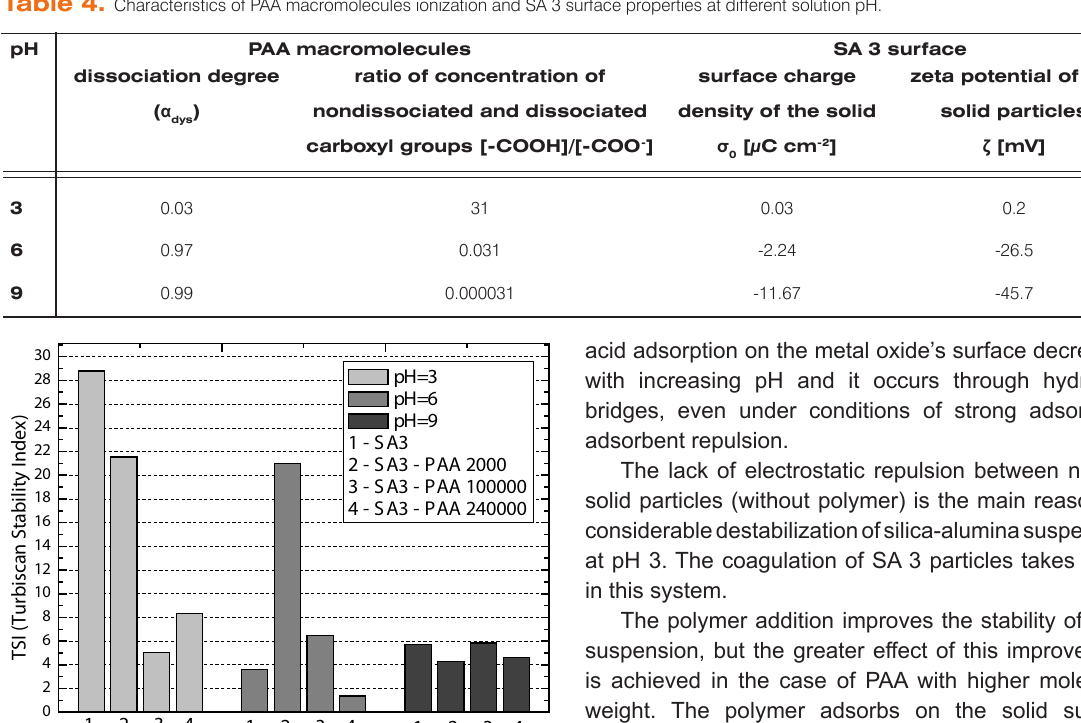
Table 4. Characteristics of PAA macromolecules ionization and SA 3 surface properties at different solution pH.